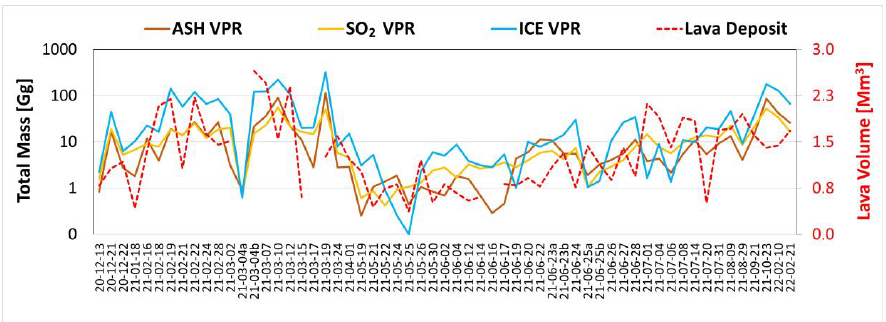
Figure A2. Comparison between VPR Ash/Ice/SO 2 total masses with the ground lava deposits ob- tained by Ganci et al. [61] from SEVIRI images.